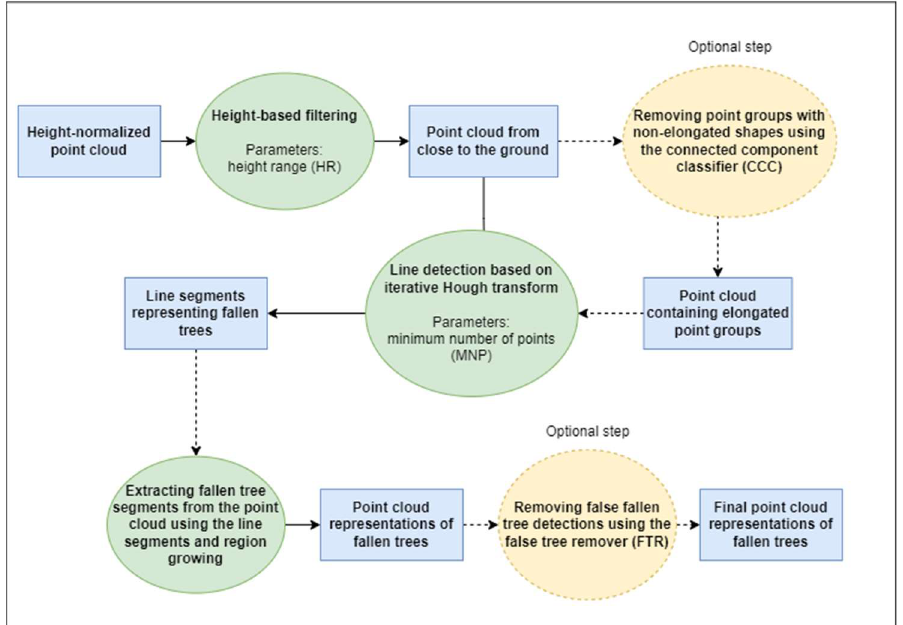
Figure 2. The steps of fallen tree detection. Refer to Table 2 for a detailed description of the parameters